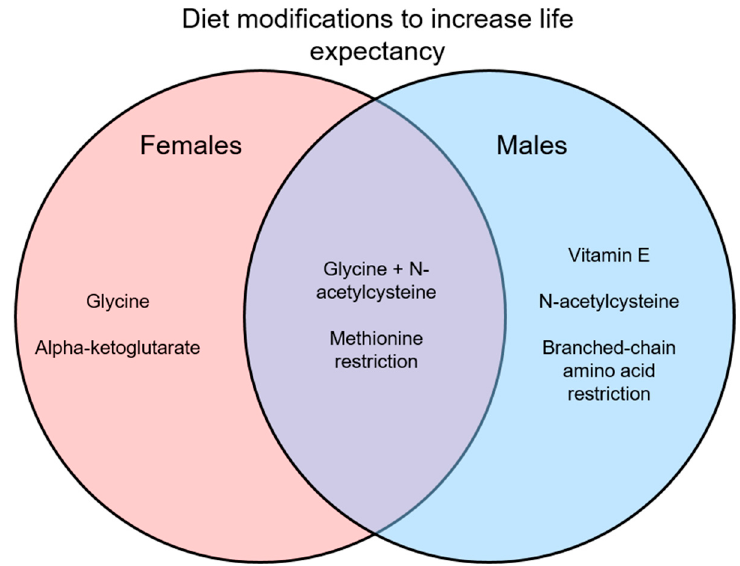
Figure 1. Interventions that increase life expectancy in males, females, or both.